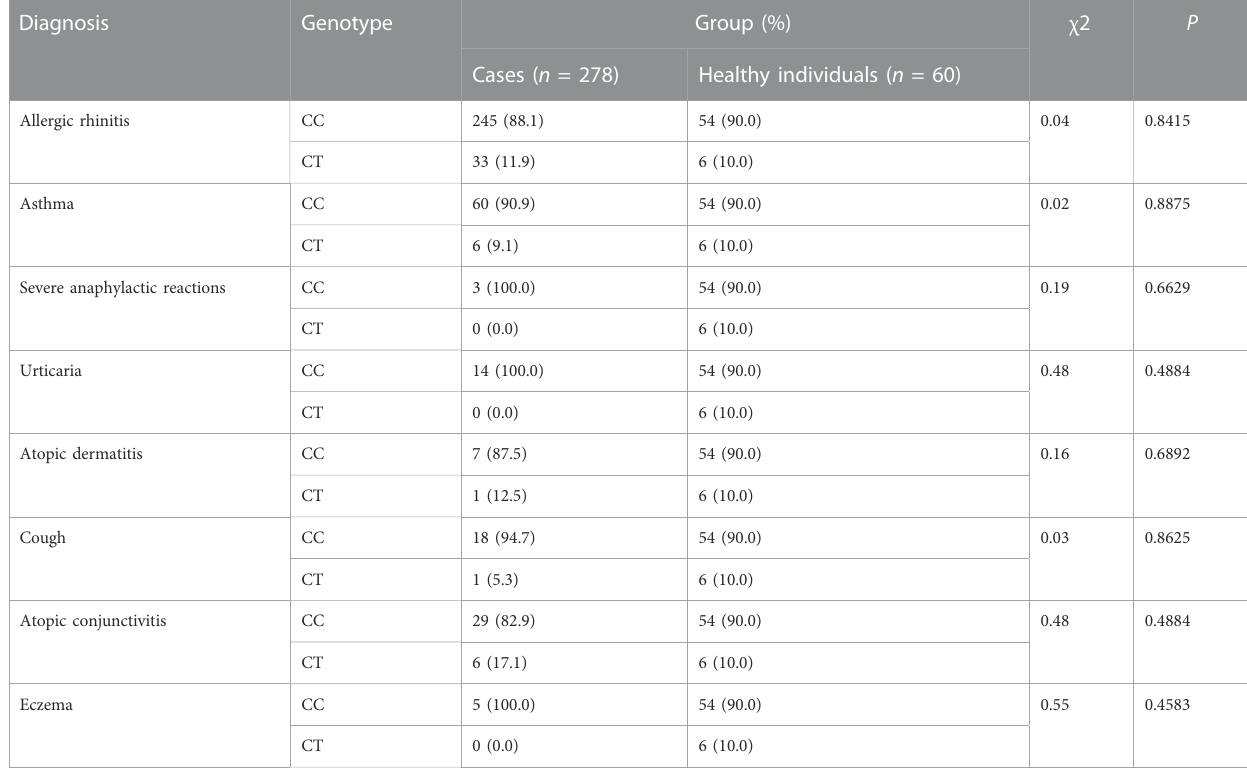
TABLE 6 Analysis of Association of GP1BA rs6065 (C5792T) with Genetic Susceptibility to